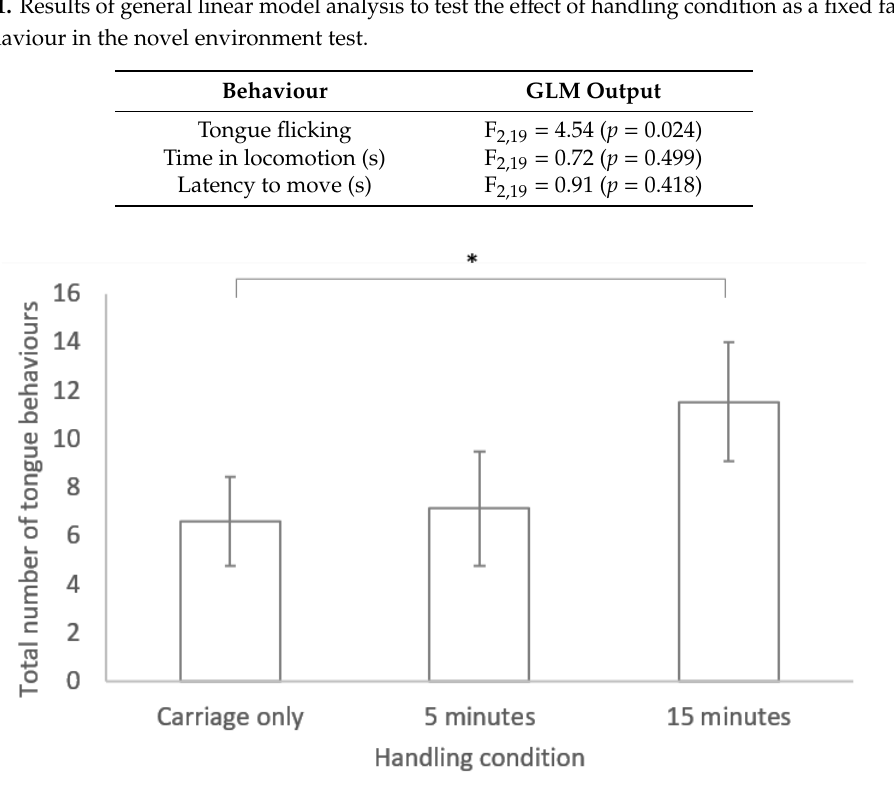
Table 2. Results of general linear model analysis to test the effect of handling condition as a fixed factor on behaviour in the novel object test. B e haviour